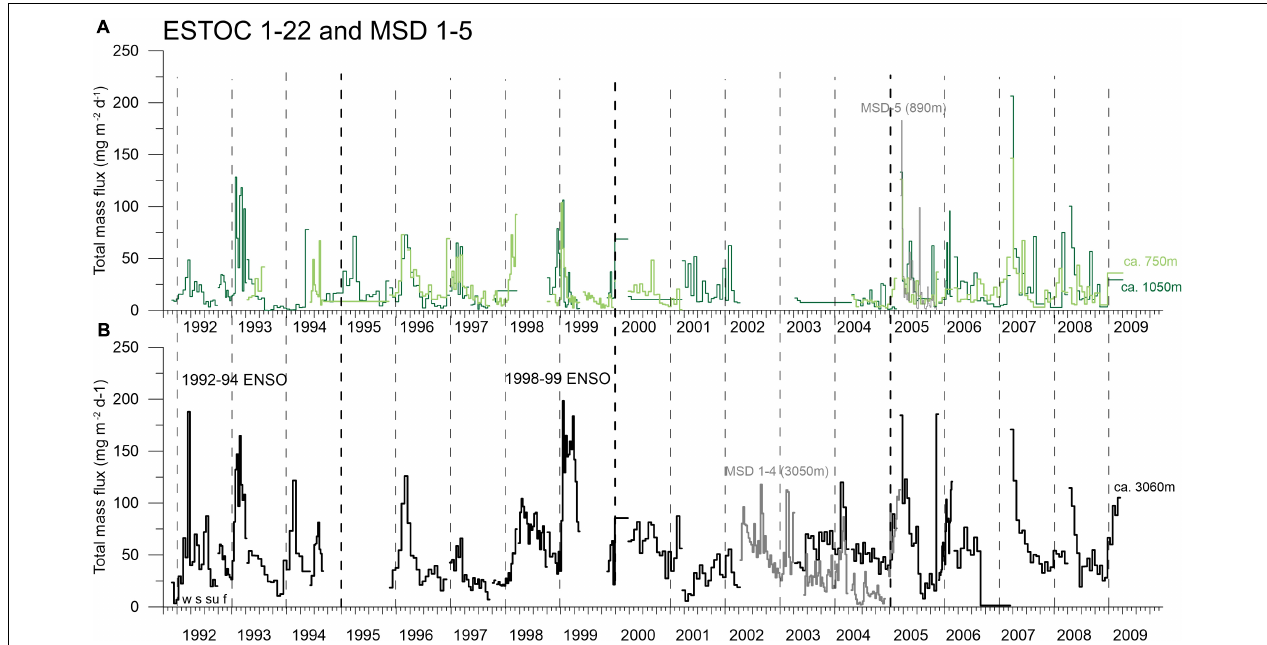
FIGURE 5 | Cup-by-cup data of total particle flux (mg m − 2 d − 1 ) at ESTOC (1–22) and the MSD-site 1–5 (see Supplementary Material and Figure 1 ) for the mesopelagic ( A: ca. 750 and 1050 m) and bathypelagic ( B: ca. 3060 m). Fluxes in ca. 750 m are only shown here to fill the gaps in the upper water column but will not be used later on for the discussion of flux seasonality. Vertical hatched lines indicate the years (with the four seasons winter = w, spring = s, summer = su, fall = f, starting on Jan. 1), and bold hatched lines indicates the 5-year